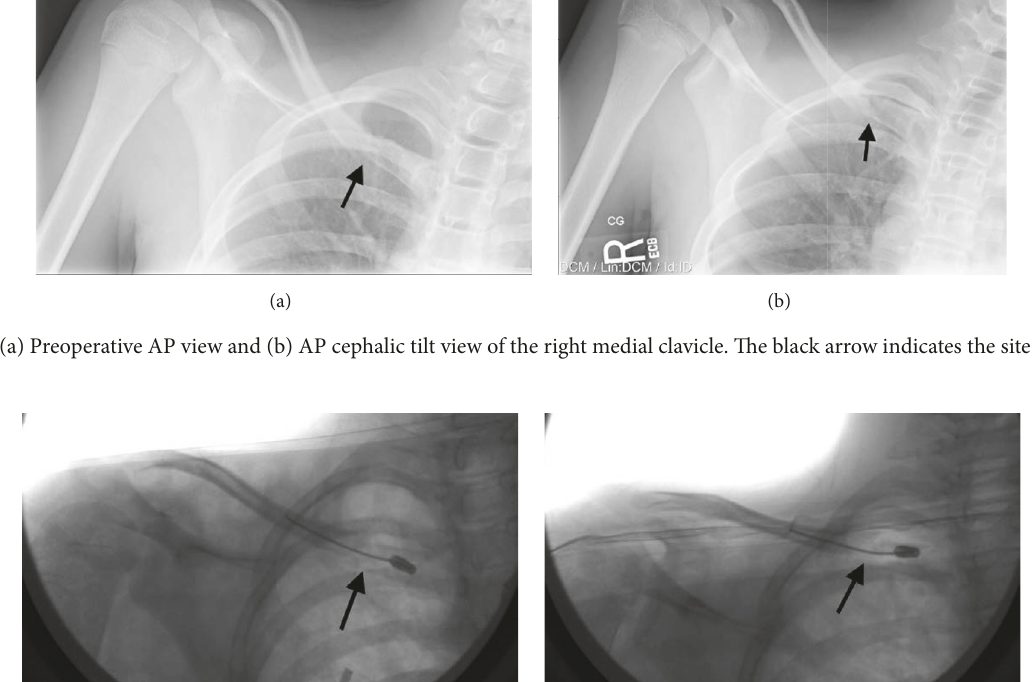
physical examination revealed no additional injury to the upper extremity. Motor function and sensation were